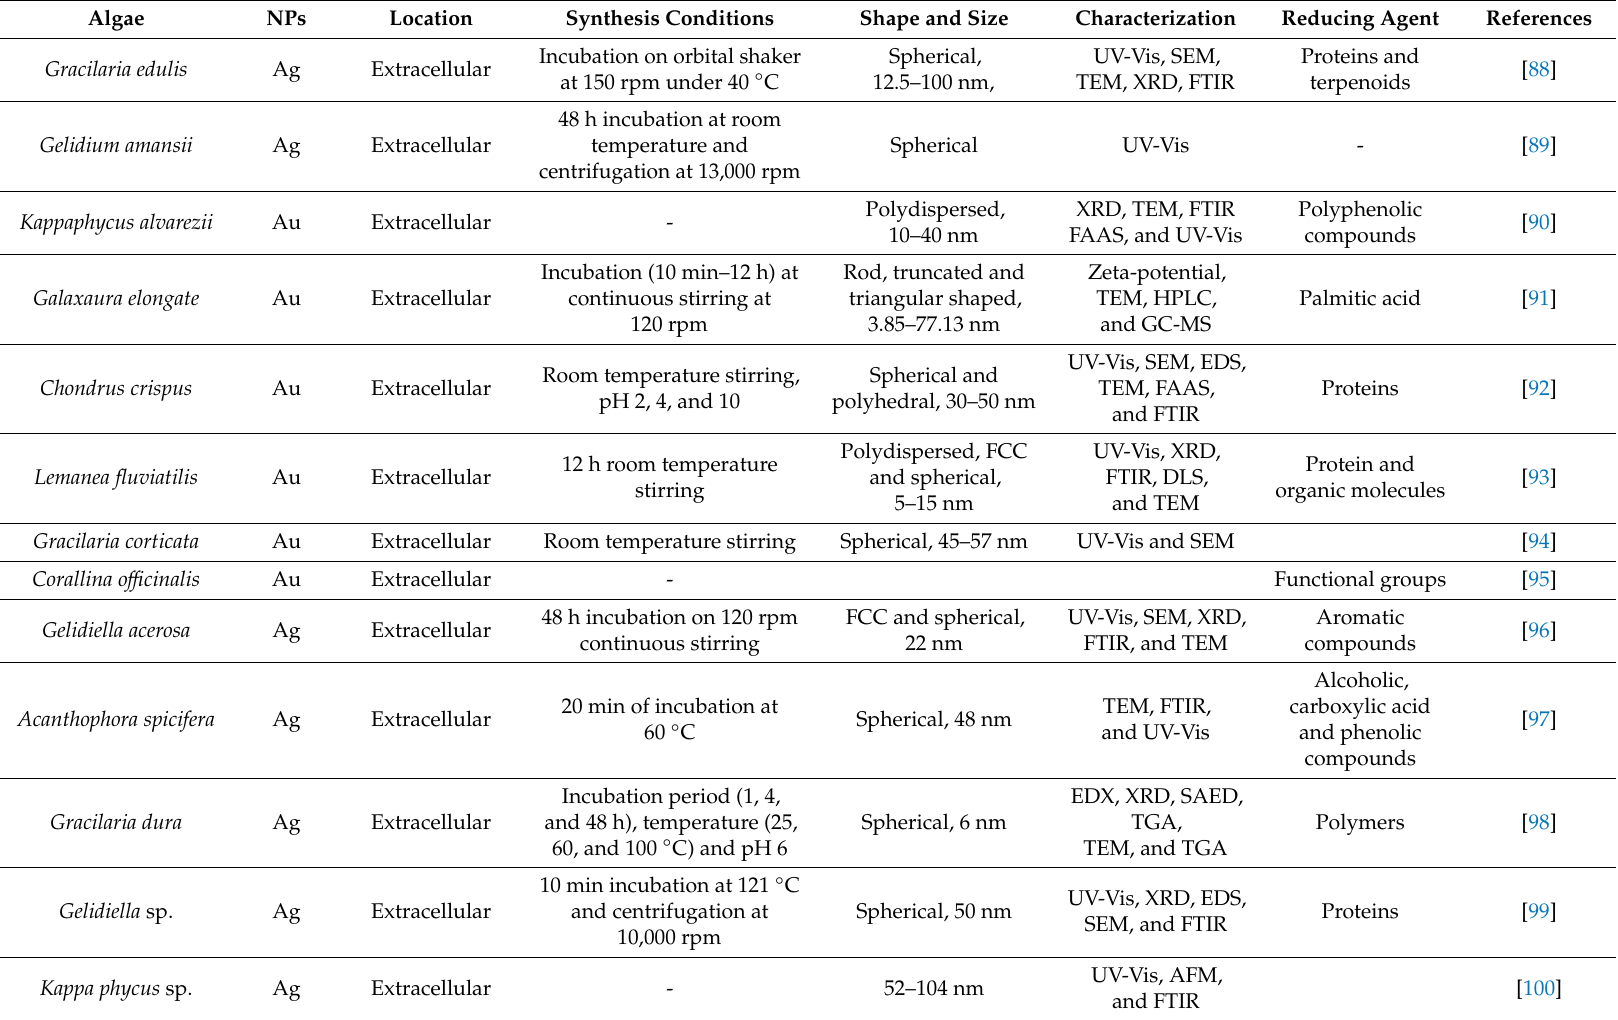
Table 2. Red algae-mediated biosynthesis of metallic